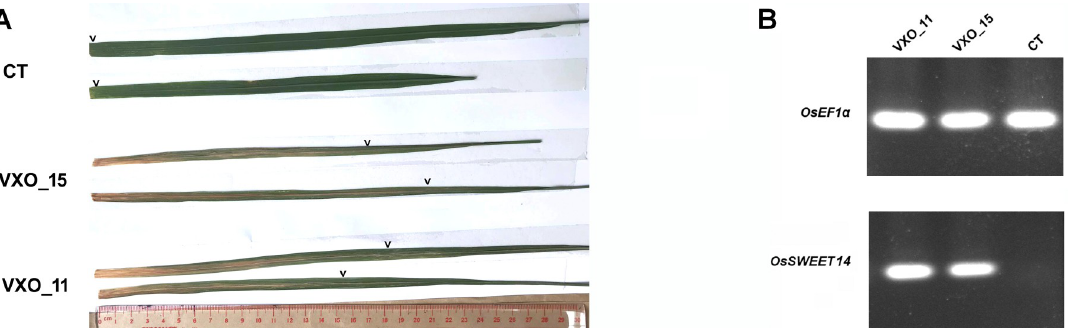
Fig 2. OsSWEET14 is likely a susceptibility gene for Vietnamese Xoo strains in rice cultivar TBR225. (A) Representative images of the disease lesions obtained 14 days after leaf clipping inoculation of TBR225 rice leaves with Vietnamese Xoo strains VXO_11 and VXO_15 or with water (CT). The chevrons above the leaves indicate the maximum visible extent of lesions away from the inoculation point on the left (B). OsSWEET14 expression pattern obtained by RT-PCR two day post-infiltration of TBR225 rice leaves with Vietnamese Xoo strains. CT Plants were inoculated with water only. The experiment was repeated three